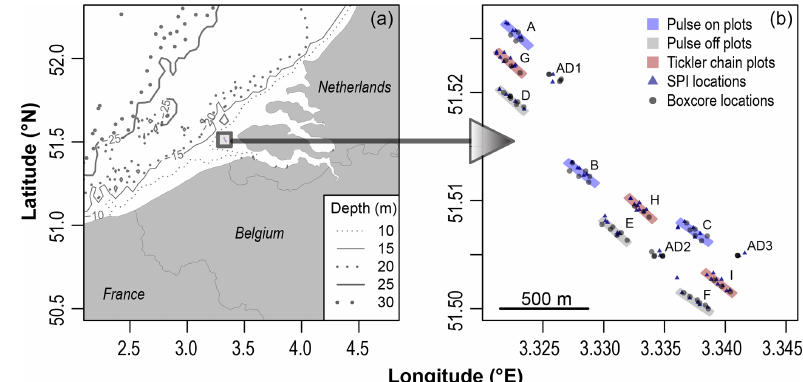
Figure 1. Geographic location of the study site (a) . Visual descriptions for experimental plots in Pulse-ON (A–C), Pulse-OFF (D–F), and Tickler (G–I) trawl treatments, untrawled adjacent stations (AD1, AD2, AD3), sediment profile imagery (SPI) locations, and box core sampling locations (b) . Experimental plots were sectioned into northwest, central, and southeast